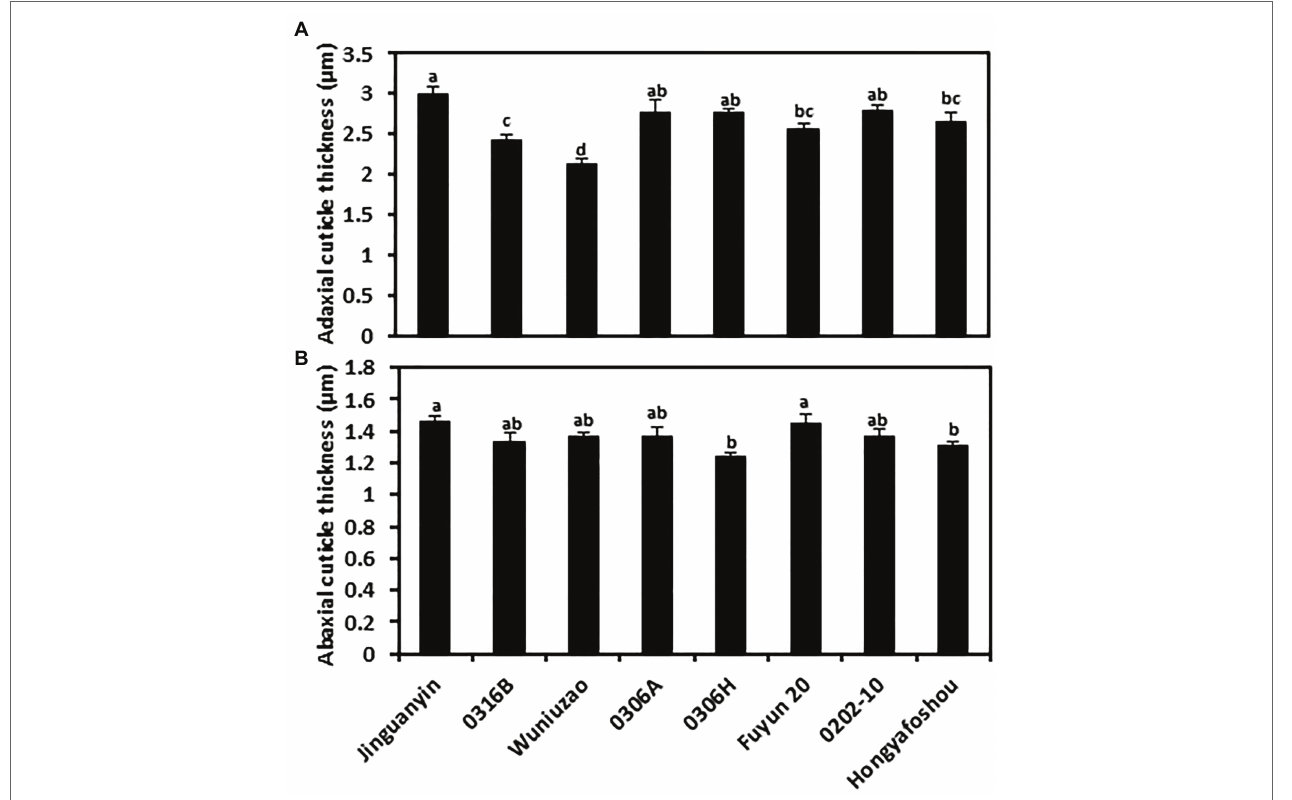
FIGURE 1 | Cuticle thickness from the adaxial and the abaxial cuticle of the eight tea germplasms. (A) The adaxial surface; (B) the abaxial surface. Different lowercase letters represent the statistical significance ( p <